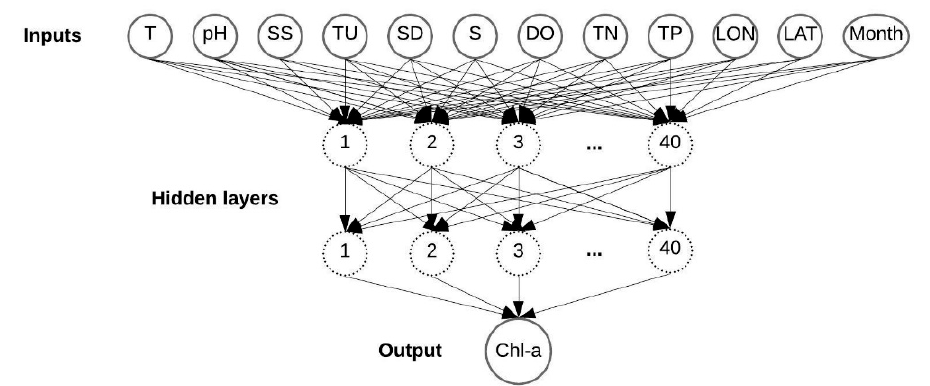
Figure 2. An multilayer neural network (MLNN) structure developed for predicting the concentration of chlorophyll-a (Chl-a) with two hidden layers and 12 variables as inputs (water temperature (T), pH, suspended solids (SS), turbidity (TU), Secchi Disk depth (SD), salinity (S), dissolve oxygen (DO), total nitrogen (TN), total phosphorus (TP), latitude (LAT), longitude (LON) and